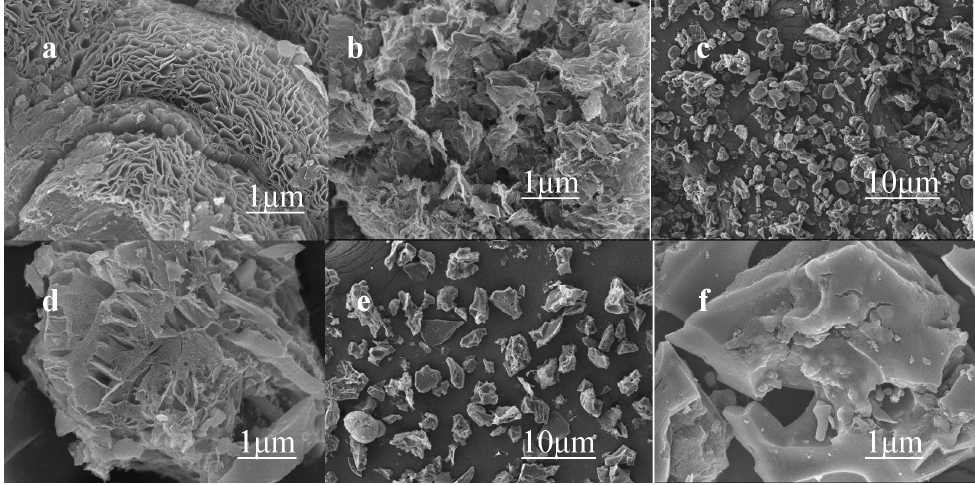
Figure 1. SEM images of NSCL-900 ( a , b ), NS-900 ( c , d ), and NNS-900 ( e , f ).